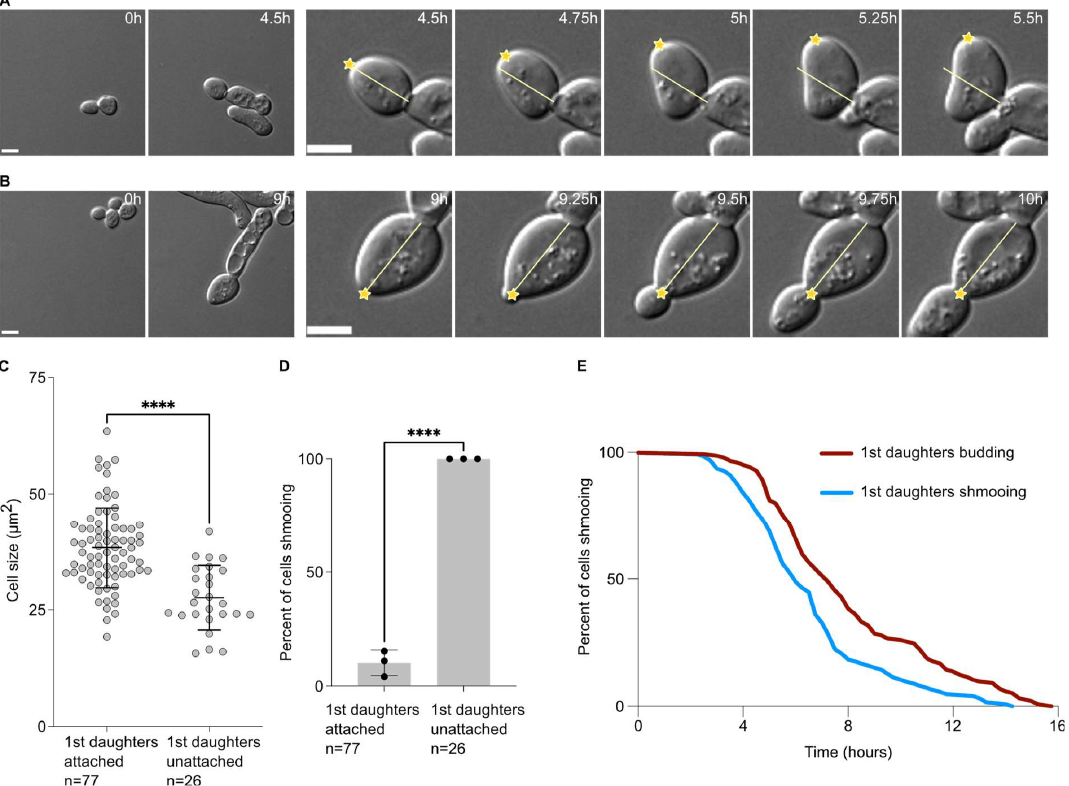
Figure 2. Attached first daughter cells are larger and more likely to bud upon birth than unattached ones. ( A ) Escape of a WT cell exposed to 7 nM of pheromone with a first daughter cell unattached. Left panel, pictures of the mother cell until the bud separates from the mother cell. Right panels, focus on the first daughter cells during the first hour after cytokinesis. The yellow line indicates the long axis on the daughter cell at the cytokinesis point. The yellow star indicates the daughter tip. Note that in this case the yellow star deviates from the yellow bar, showing that the first daughter cell is free to move. Scale bar = 5 µ m. ( B ) Same as A for an attached first daughter cell. Note that the yellow star does not deviate from the yellow bar, showing that the first daughter cell is not free to move. Scale bar = 5 µ m. ( C ) Cell size (area) in µ m 2 of the 1st daughter cells, either attached or unattached to their mother cell. The variable n = number of cells obtained from 3 independent experiments. The **** = p value < 0.0001 obtained from an unpaired two-tailed t -test. ( D ) Percent of cells shmooing, whether they are attached or unattached to their mother cells upon birth. The variable n = number of cells obtained from 3 independent experiments. The **** = p value < 0.0001 obtained from an unpaired two-tailed t -test. ( E ) Percentage of initial cells still shmooing after the indicated time. The variable n > 154